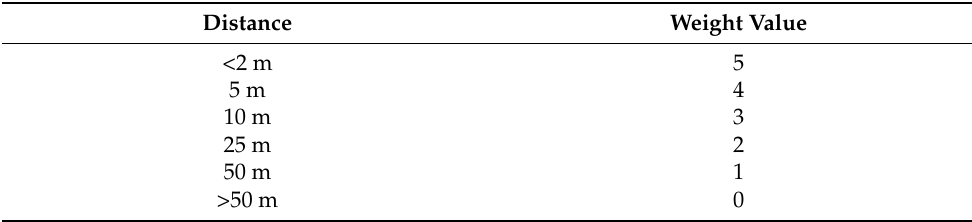
Table 2. Distance from water features: buffer distances and associated weighted value. Higher weight values are areas closer to water